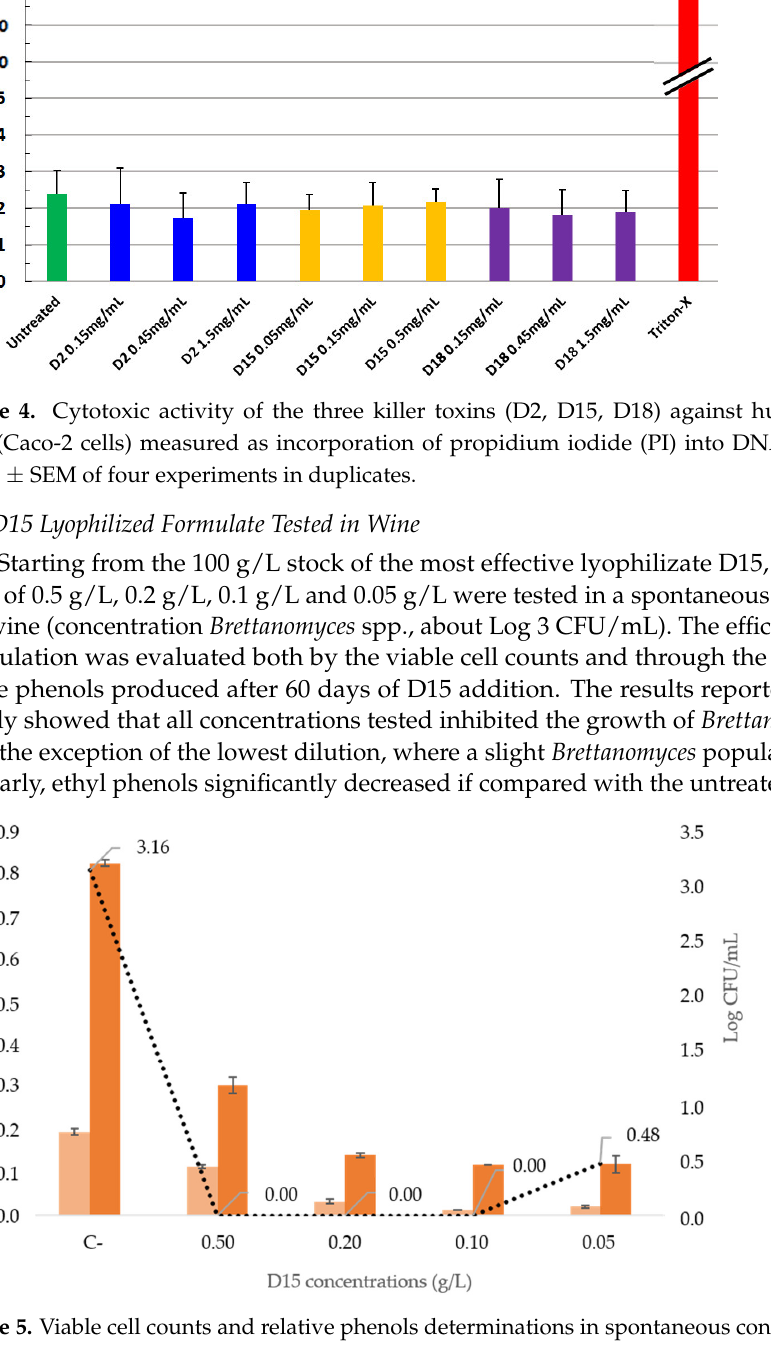
Figure 5. Viable cell counts and relative phenols determinations in spontaneous contaminated wine incubated for 60 days. Different dilutions starting from 100 g/L of D15 lyophilized stock were assayed. ( ), ( ) and ( ) represent 4-ethyl guaiacol and 4-ethyl phenol concentrations and Log CFU/mL, respectively. C- represent the negative control, where no killer toxin was added. Phenols determinations are reported as mean value ± standard deviations (error bars).